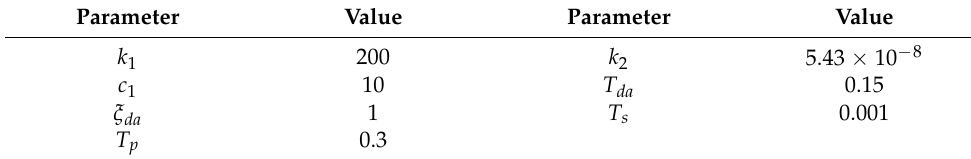
Table 2. Parameters of the controller.